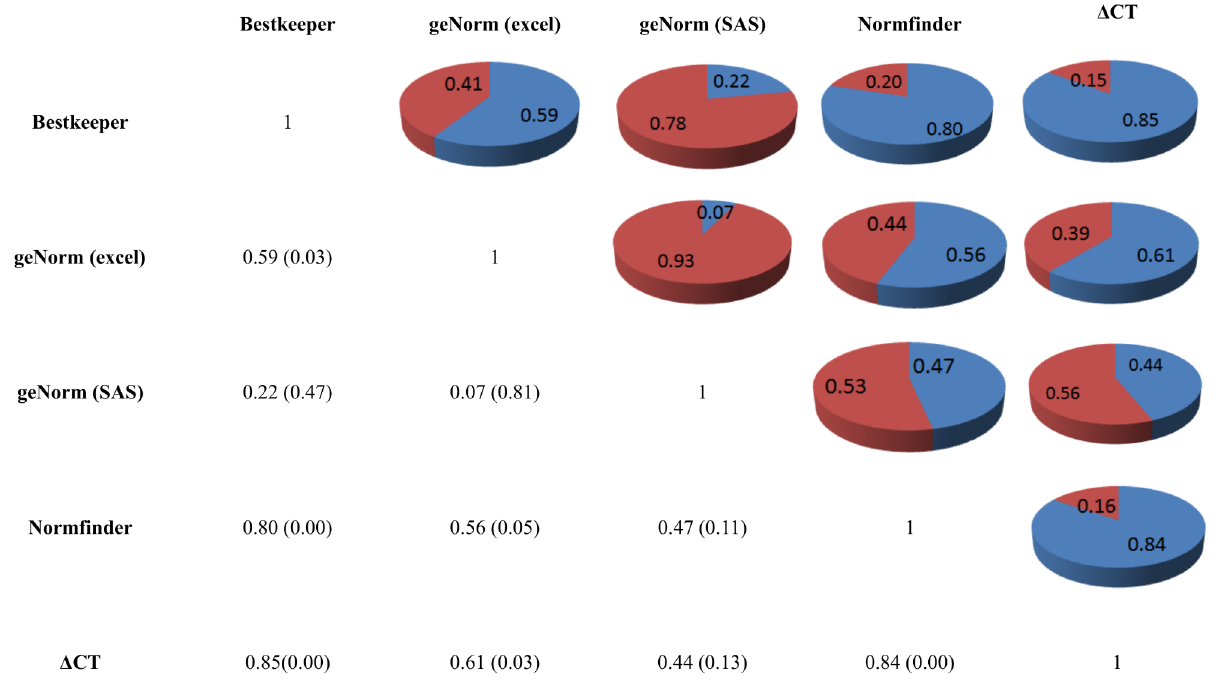
Fig 4. Spearman correlation matrix between five different stability algorithms. A correlation matrix was built between BestKeeper, NormFinder, geNorm Excel, geNorm SAS, and Δ Ct method. P-value are described are in parenthesis.